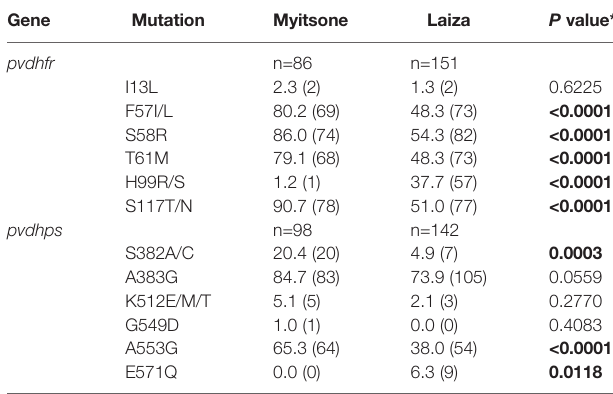
TABLE 2 | Prevalence distribution of pvdhfr and pvdhps gene mutations among two sites. Gene